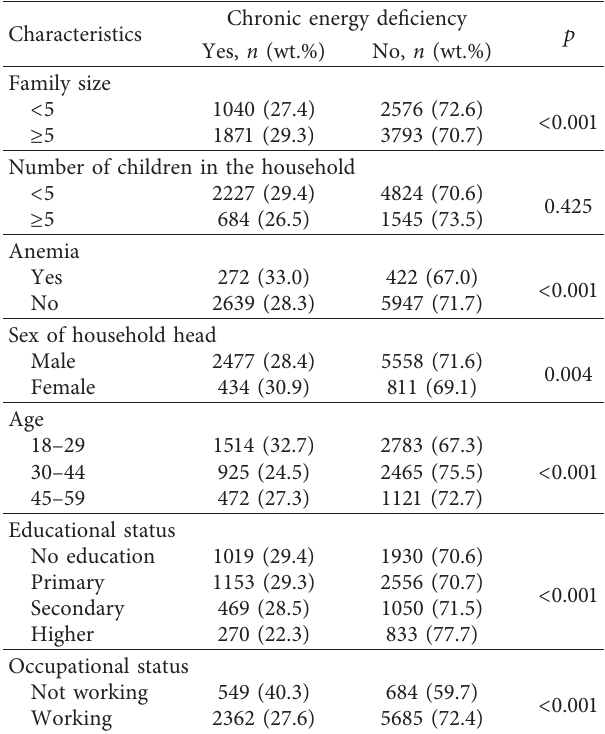
Figure 1: Nutritional status of adults aged 18–59 years in Ethiopia: EDHS 2016 ( N � 9280). Table 2: Characteristics of the study sample by chronic energy deficiency ( N � 9280).